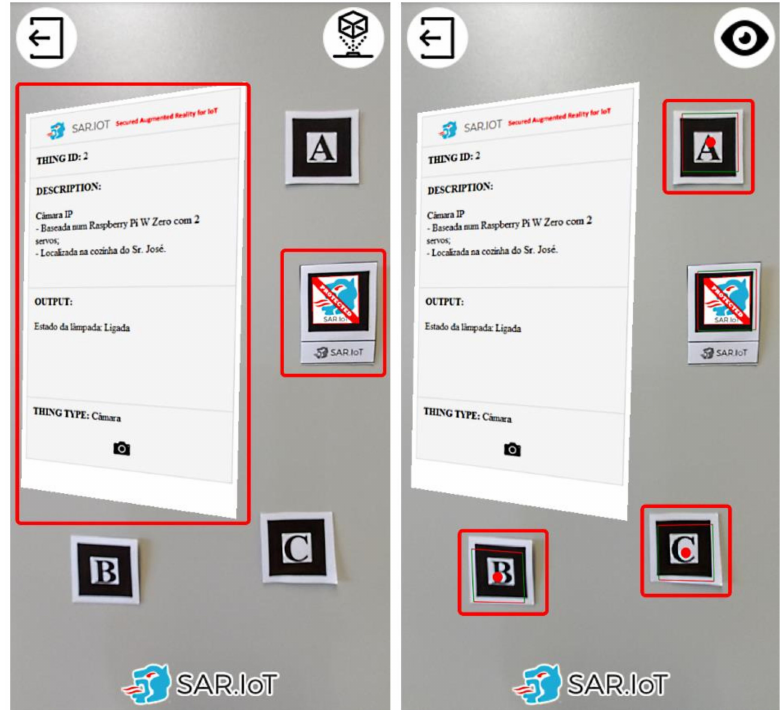
Figure 18. Normal mode ( left ) and debug mode ( right